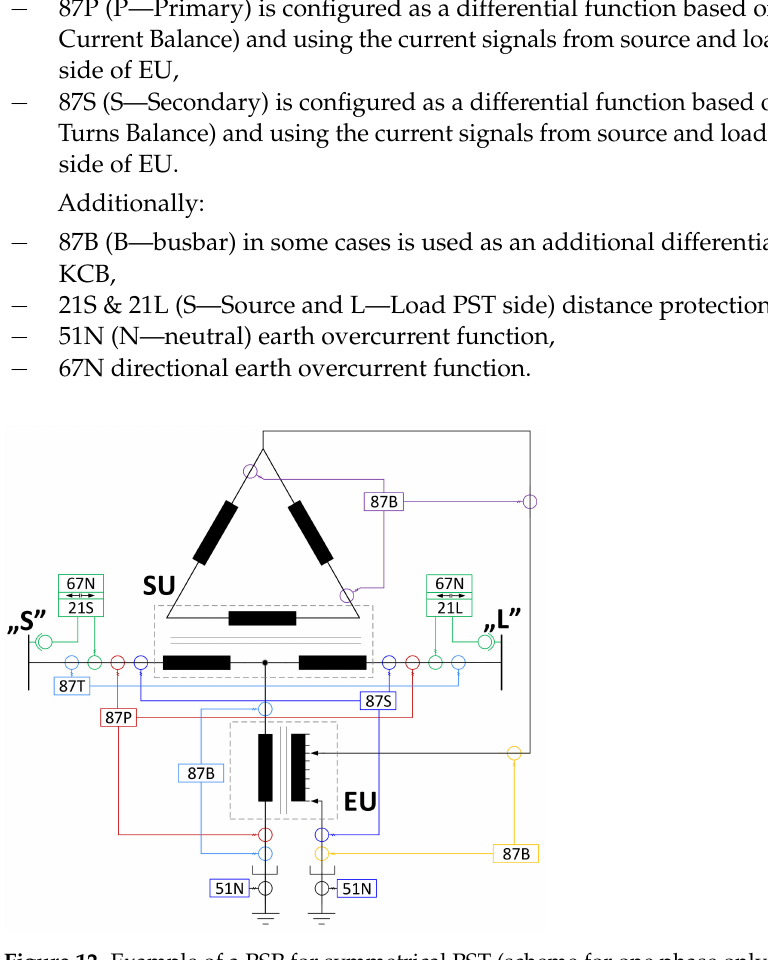
Figure 12. Example of a PSP for symmetrical PST (scheme for one phase